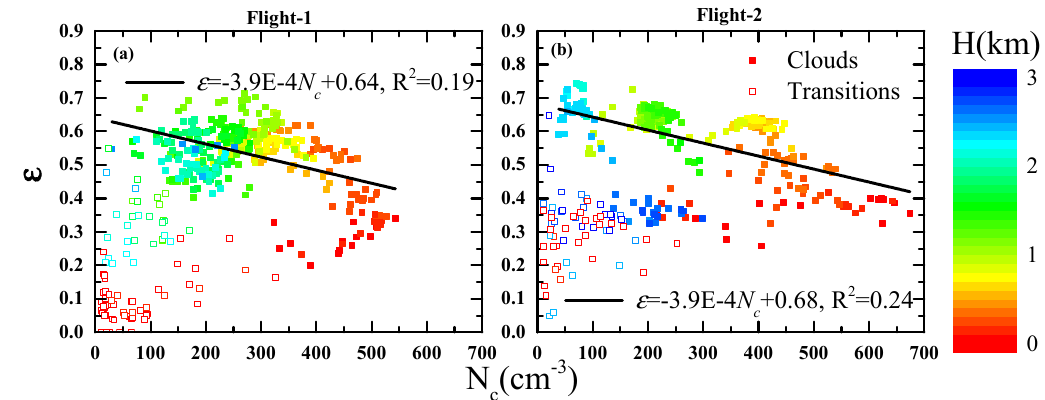
Figure 4. Relationship between cloud droplet concentration ( N c ) and relative dispersion ( ε ). The color scheme denotes the height above the cloud base (H). The black lines are linear fittings of ε − N c in clouds. Figure 4( a ) and ( b ) are for the first and second flights, respectively.